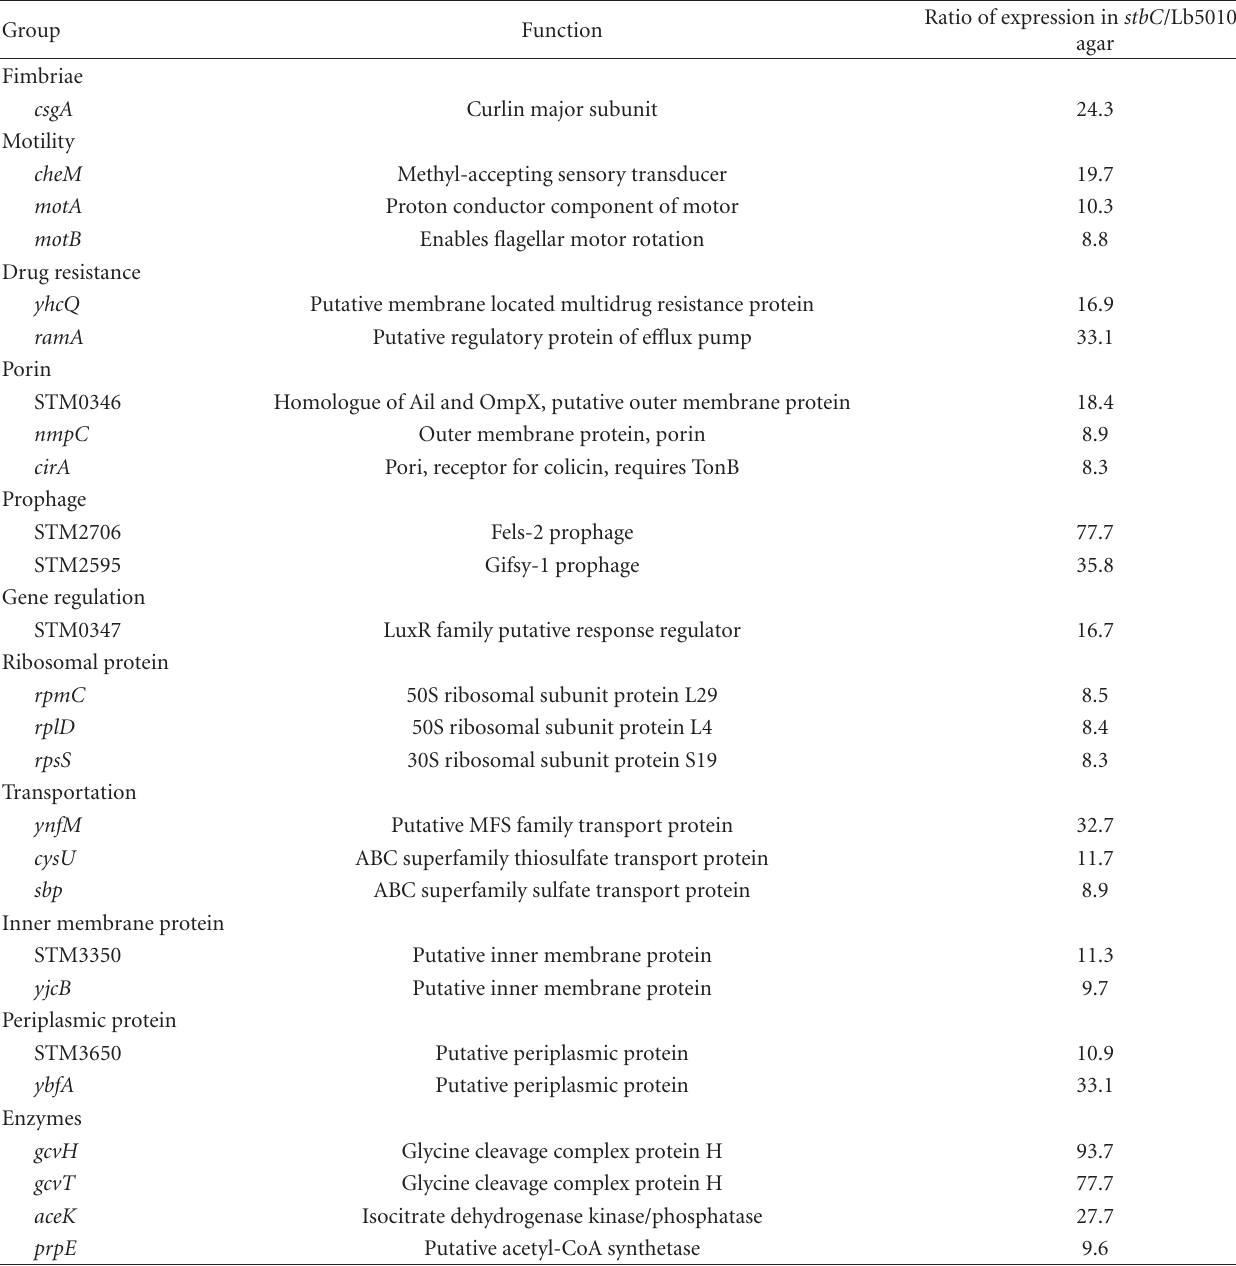
Table 3: Identification of selected genes of Salmonella enterica subsp. enterica serovar Typhimurium stbC mutant strain grown on LB agar by microarray